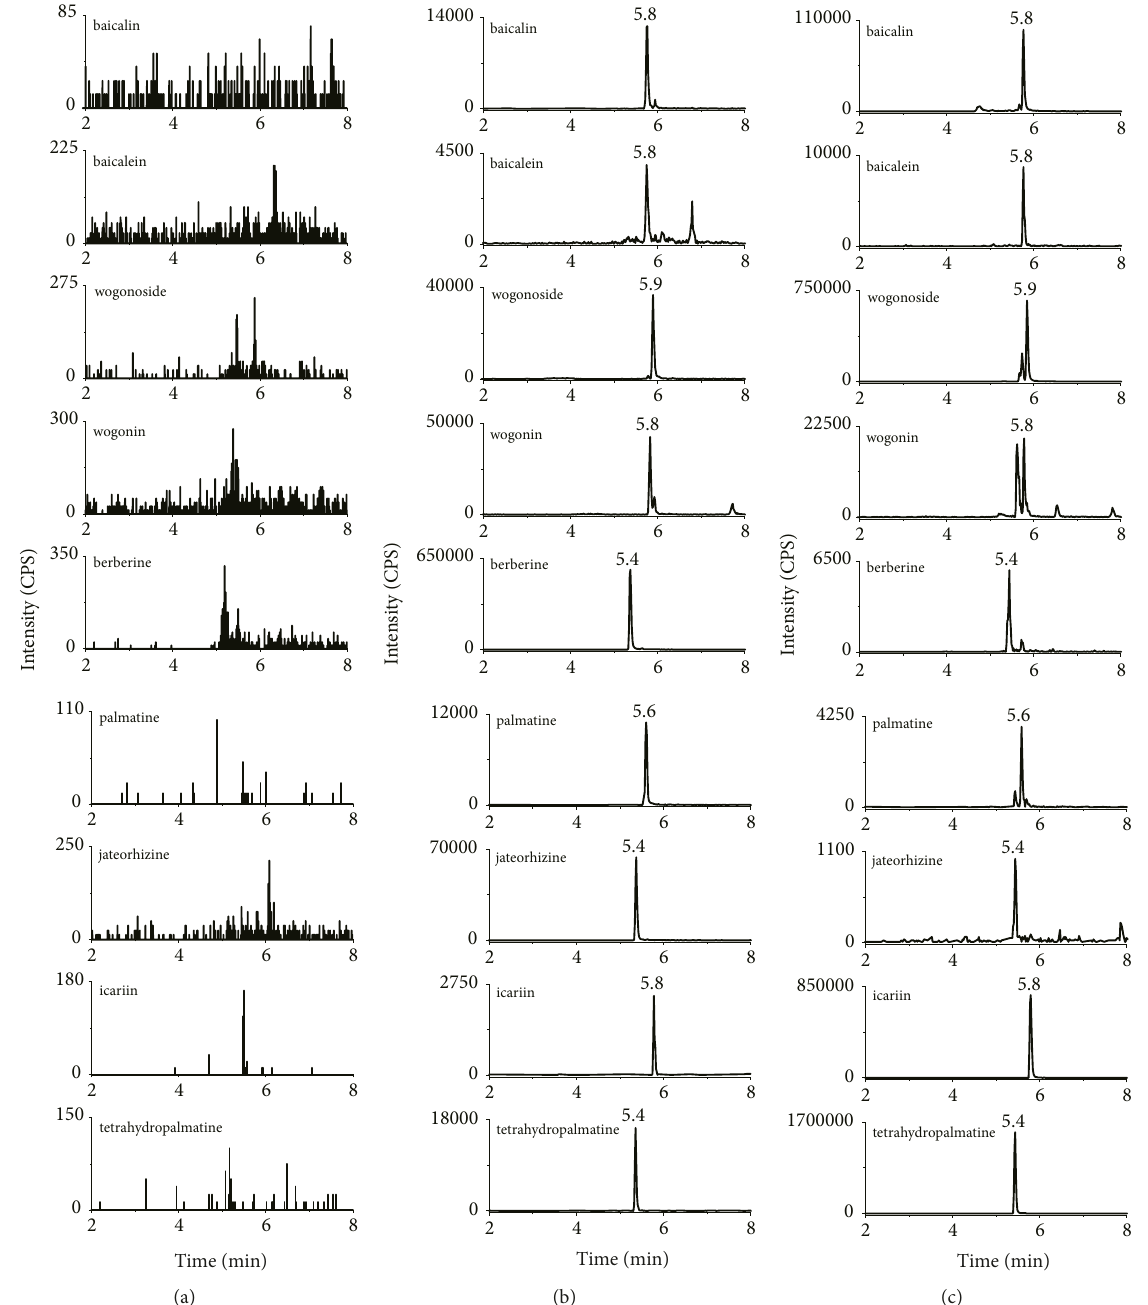
Figure 2: The MRM spectrum of each component (a) blank plasma; (b) blank plasma spiked with analytes and IS; (c) rat plasma sample collected after i.g. administration of